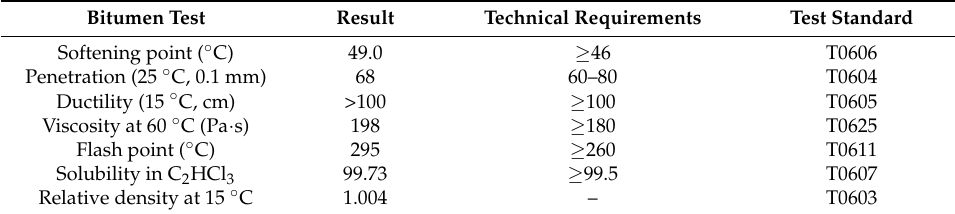
Table 1. Physical and chemical properties of bitumen.